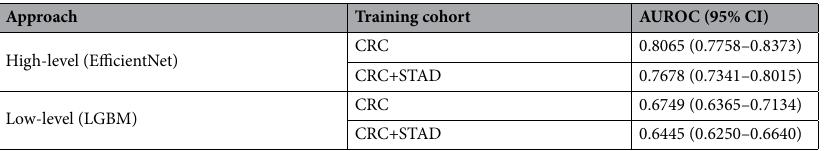
Table 1. Comparison of performance of high- and low-level approaches. Note that performances are measured only in the test set of the CRC cohort. p = 0.046 for between AUROCs of high-level (CRC) and high-level (CRC+STAD), p = 0.085 for between AUROCs of low-level (CRC) and low-level (CRC+STAD), − 5 p = 7.4 × 10 for between AUROCs of high-level (CRC) and low-level (CRC). p values are calculated from Student’s t test. The critical significance level adjusted by Bonferroni correction is p = 0.025. AUROC area under the receiver operating characteristic curve, CI confidence interval, LGBM light gradient boosting machine, CRC colorectal, STAD